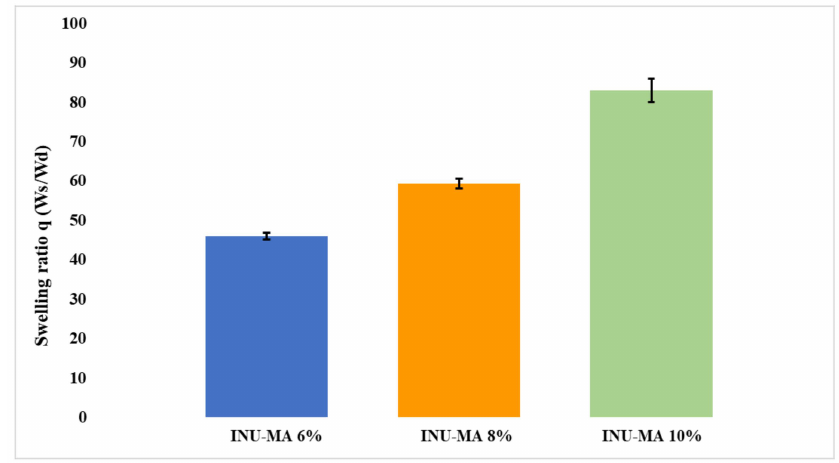
Figure 6. Swelling studies in water of I-series polyHIPEs ( n = 3 for each sample, values are expressed ±